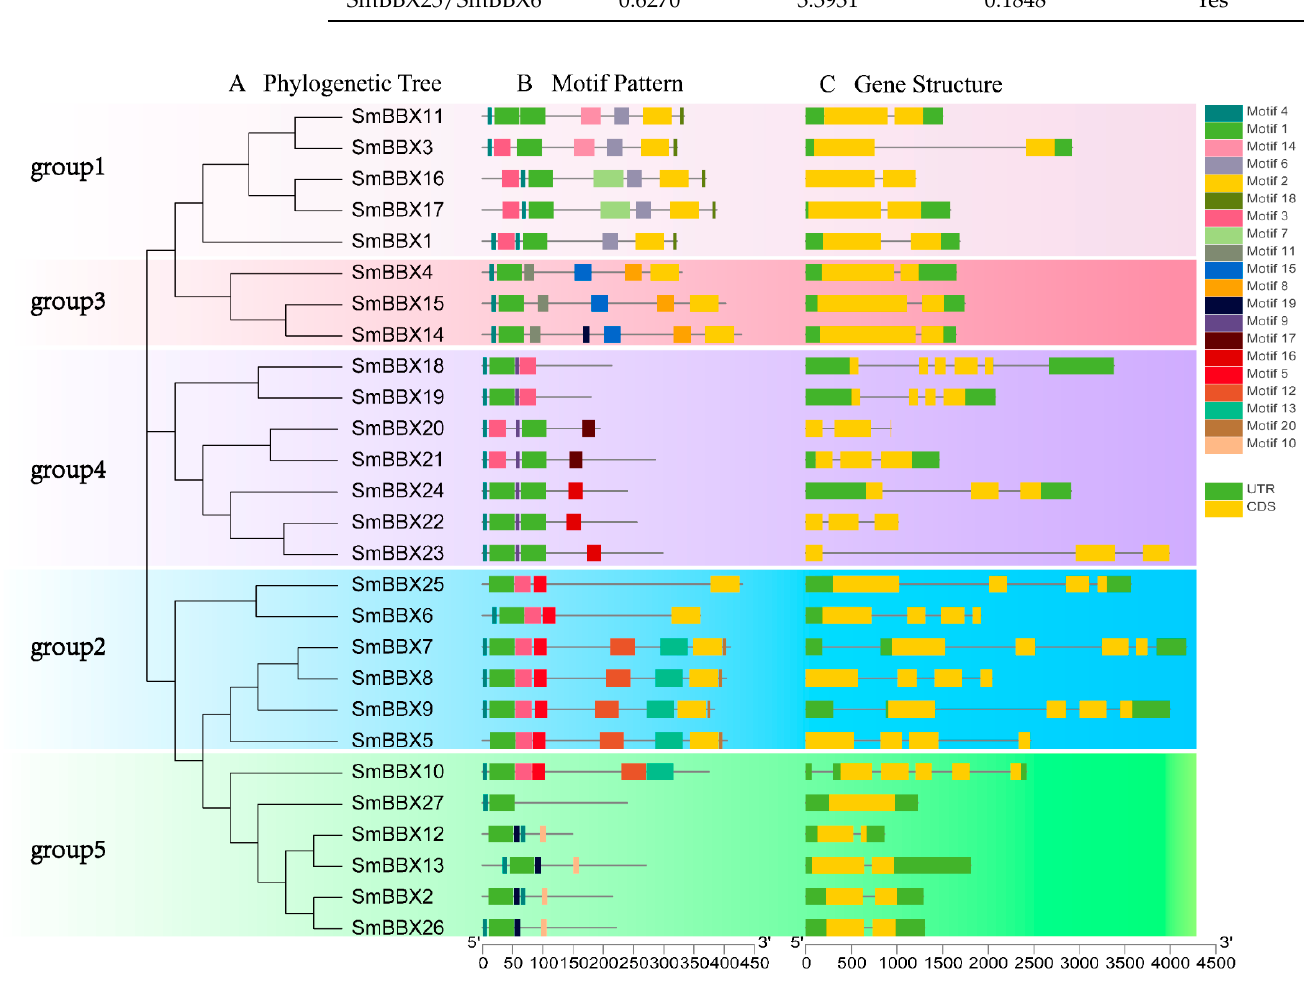
Figure 4. Evolutionary tree, conserved motifs, and gene structures of SmBBXs gene family. ( A ) Phylogenetic relationship of SmBBXs proteins. Five subgroups (groups 1–5) are indicated in different colors; ( B ) conserved motifs of SmBBX proteins. The size of the conservative motif is proportional to the square size; ( C ) structure of SmBBX genes. Green rectangles refer to UTR, and yellow rectangles refer to CDS.